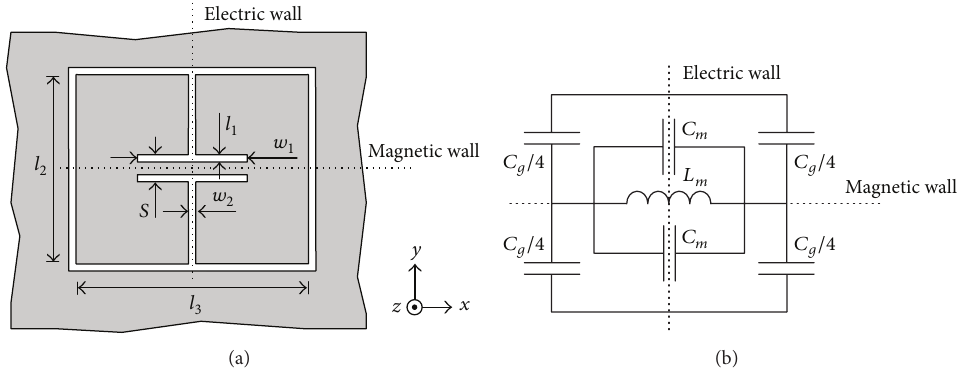
Figure 4: Typical topology of an MLC (a) and its equivalent circuit model (b). The relevant dimensions and the electric and magnetic walls are indicated.